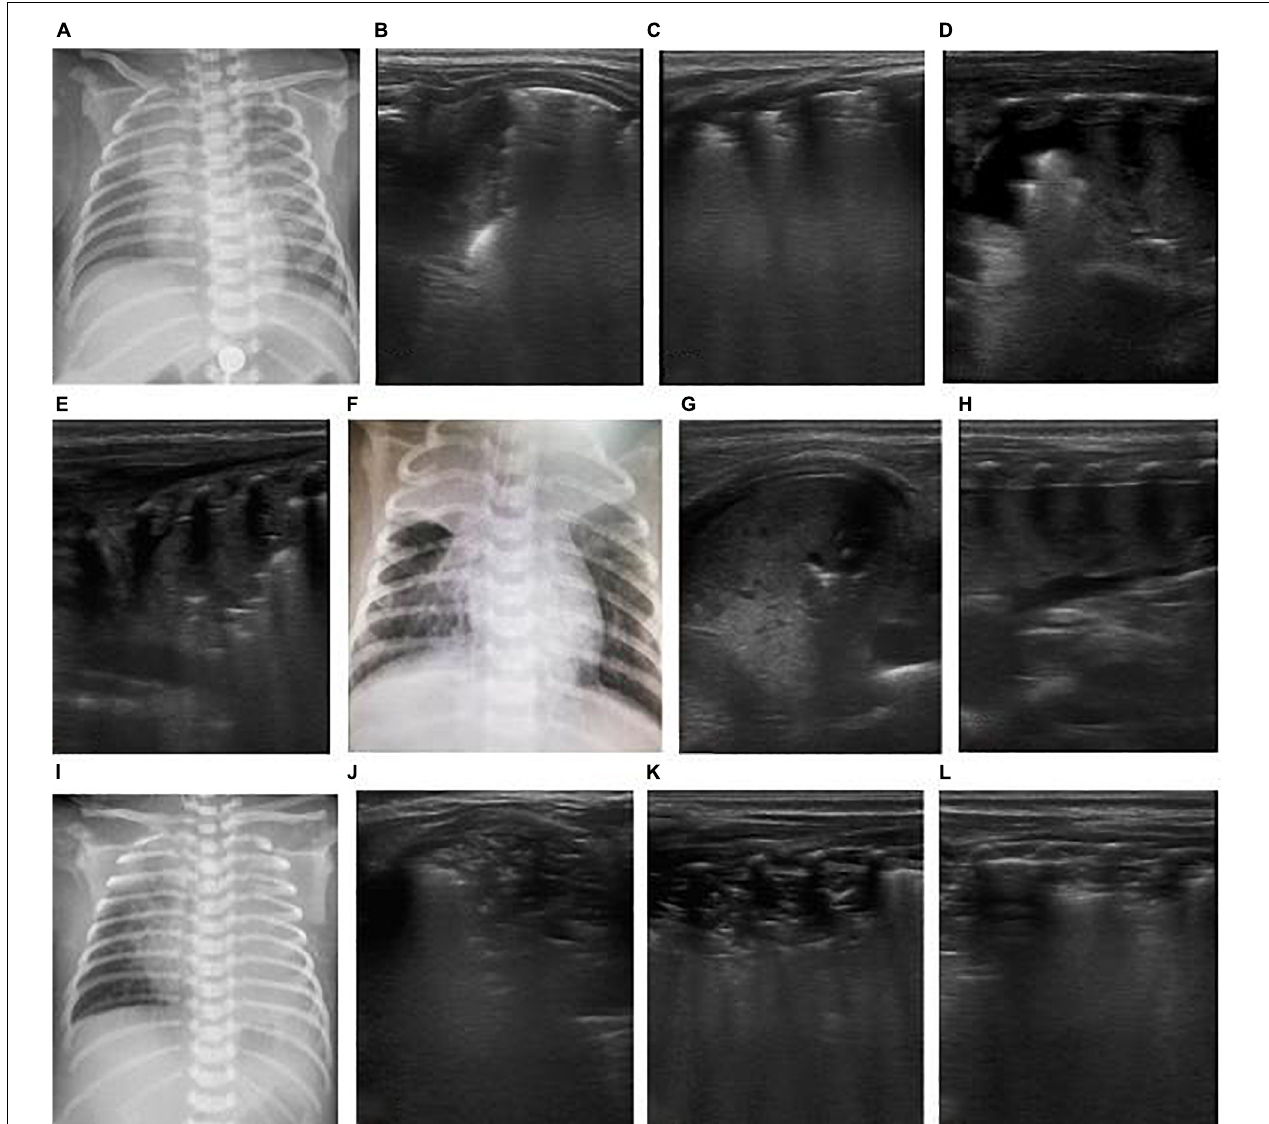
FIGURE 6 | The patient was a 26-day-old, full-term neonate and admitted to the hospital due to cough and shortness of breath for 4 days and aggravation for 2 days. The neonate had a spasmodic cough, and his mother had a history of cough. The nucleic acid test of respiratory virus suggested pertussis. It was diagnosed as severe pertussis pneumonia. On the admission day, LUS showed bilateral consolidation with atelectasis in the right upper lung (B,C) , and chest X-ray showed consolidation of the right upper lung (A) . After admission, the patient was given anti-infection and CPAP respiratory support, but after half a day, the respiratory distress progressively worsened, and blood oxygen decreased. Re-examination by LUS showed increased consolidation of both lungs as a hepatoid echo and developed to a large area atelectasis. Bronchial inflation sign was reduced, and consolidation was severe (D–F) . Hence, mechanical ventilation was provided via endotracheal intubation for respiratory support. An emergency exchange transfusion was performed. WBC increased again after 3 days of hospitalization, and atelectasis was aggravated (G–I) , and exchange transfusion was performed again. After the second exchange transfusion, ultrasound monitored pulmonary atelectasis was improved (J–L)